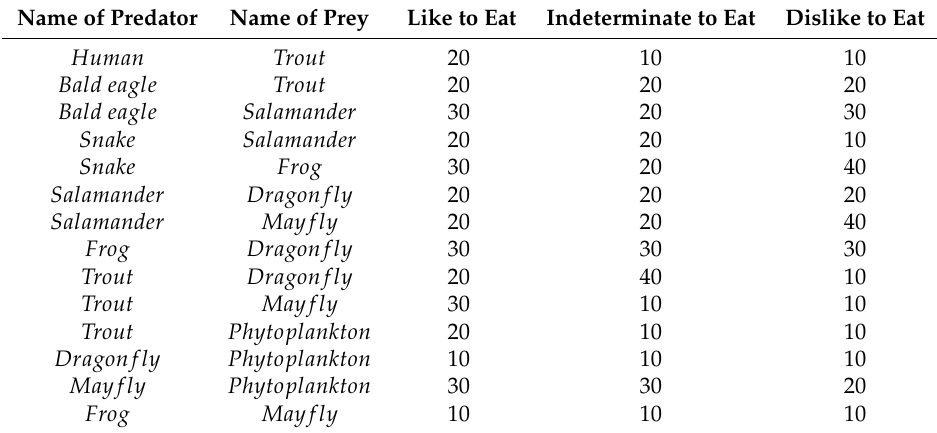
Table 7. Likeness, indeterminacy and dislikeness of preys and predators.